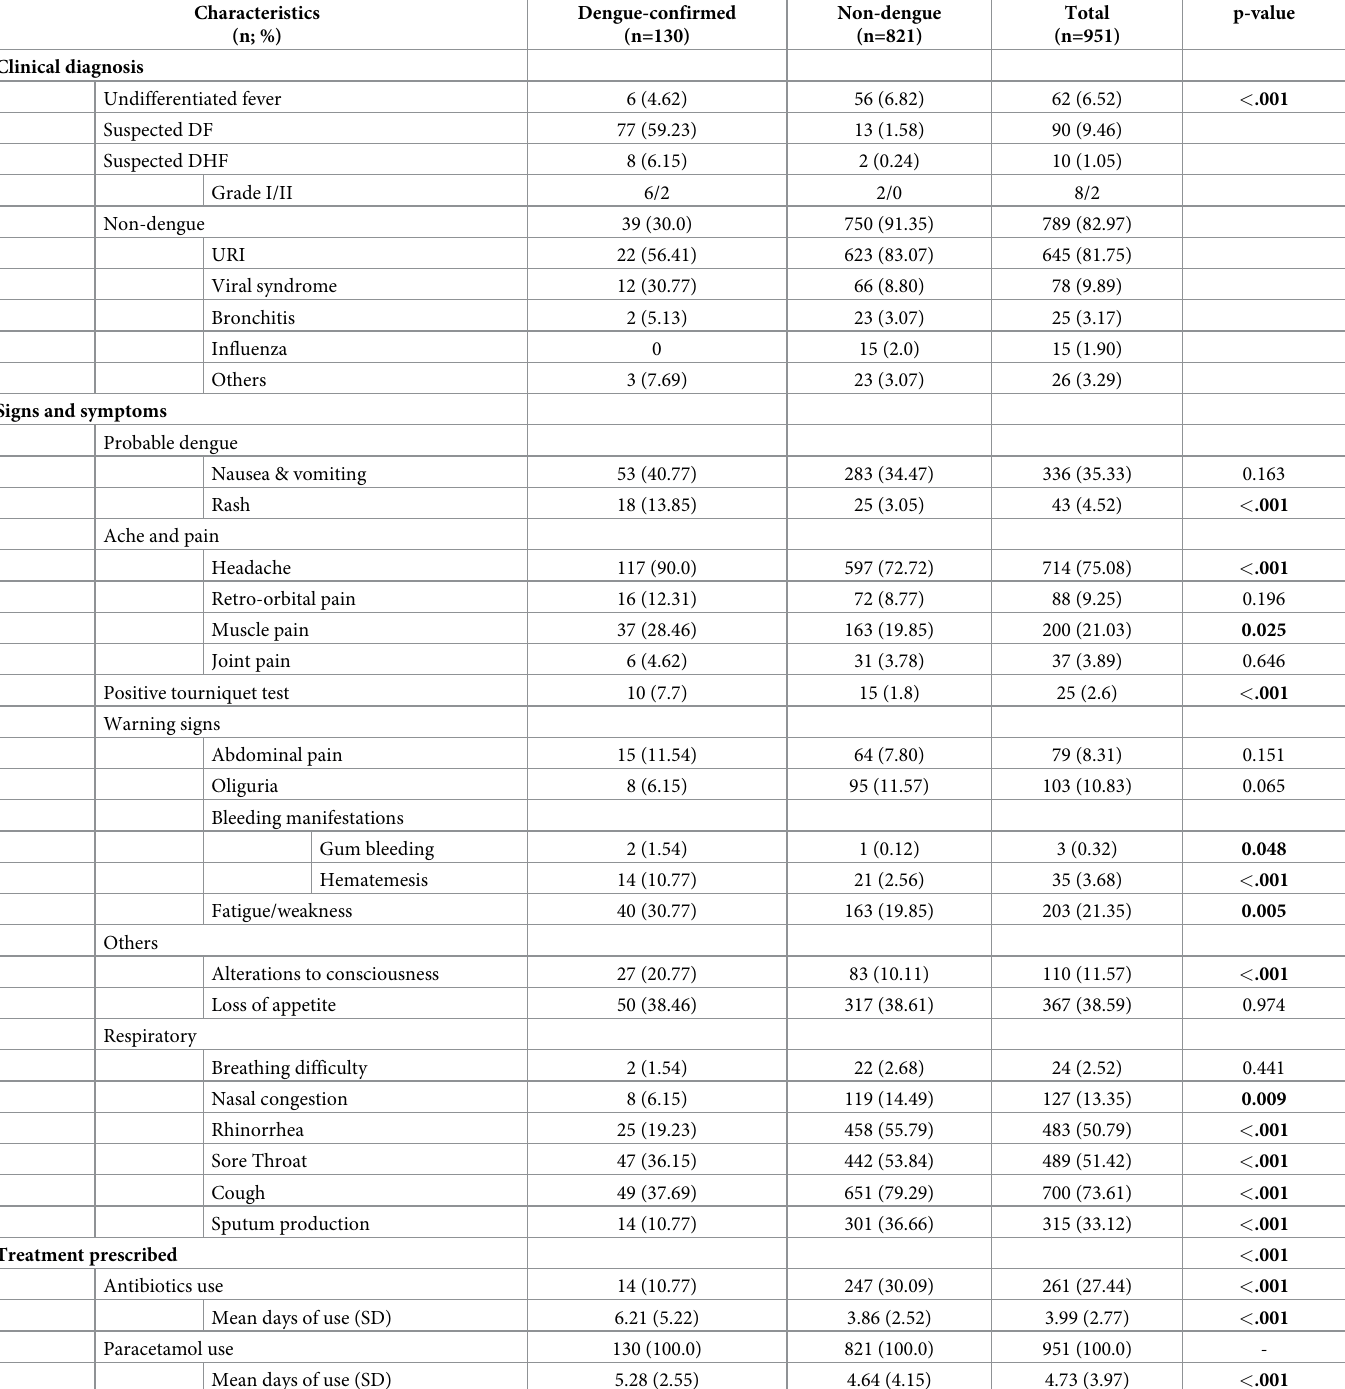
Table 2. Clinical characteristics of the dengue-confirmed and non-dengue patients as well as total enrolled study patients with non-localizing febrile illness from the health facility-based fever surveillance established in Bang Phae district, Ratchaburi province, Thailand in 2011–2016. Characteristics (n;